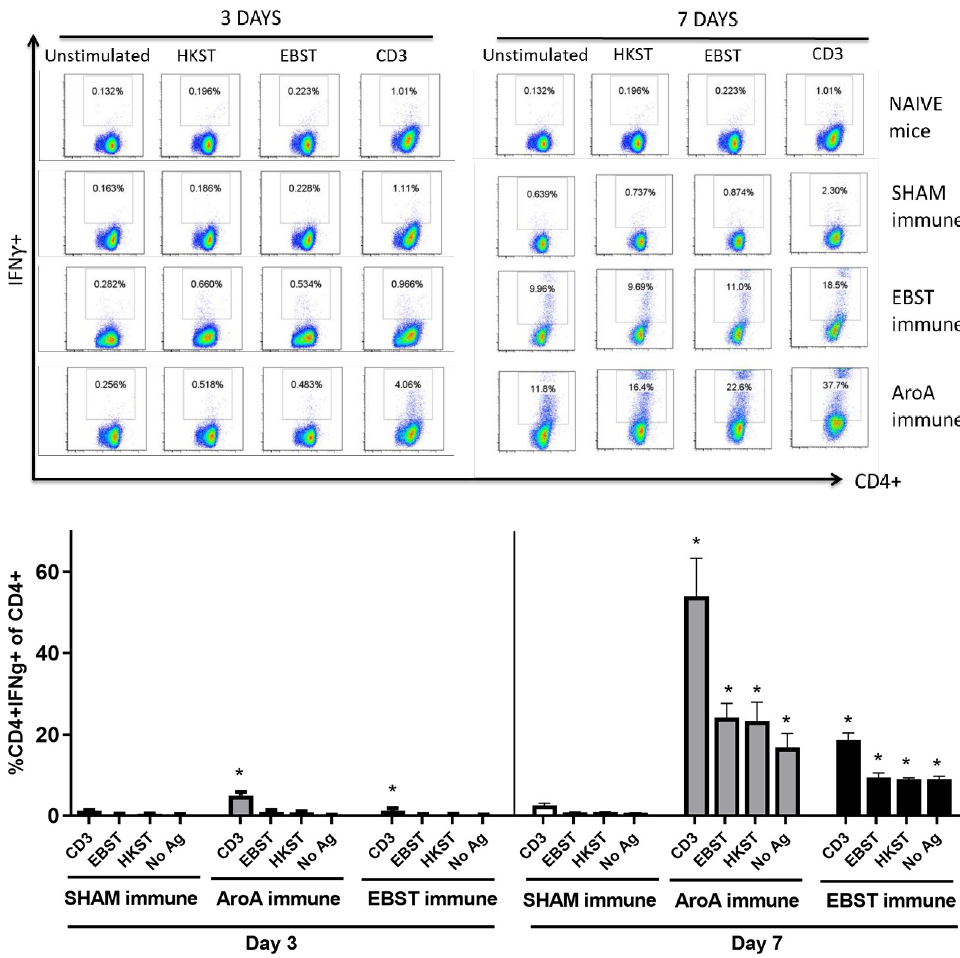
Fig 7. EBST immune mice exhibit Salmonella specific CD4 + IFN γ + T cell responses during virulent ST challenge. Individual EBST immune, AroA immune, and Sham immune mice were infected with virulent ST and at 3 days and 7 days post infection. Splenocytes were measured for production of IFN γ by antigen specific CD4 + T cells using intracellular cytokine staining (ICS). Antigens used were EBST and HKST (2 x10 7 cells/ well) and anti-CD3 antibody as a positive control and unstimulated splenocytes as a negative control. Percentages in the gated region of dot plots indicate the proportion of CD4 + IFN γ + of total CD4 + splenocytes (Fig 7A). Data are representative of three-five individual mice per group. The bar graph data represents mean ± SEM of 3–5 mice per group. The Y axis represents percentage of CD4 + IFN γ + of total CD4+ splenocytes (Fig 7B) on days 3 and 7. Statistics were determined for comparisons between group for each antigen at the indicated day. � , p �